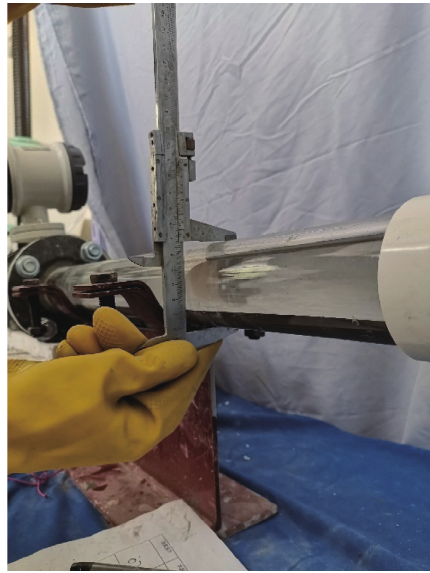
Figure 5: Thickness of the slurry deposition in pipes. Table 4: Analysis of the slurry deposition thickness in the 70 mm diameter pipe.